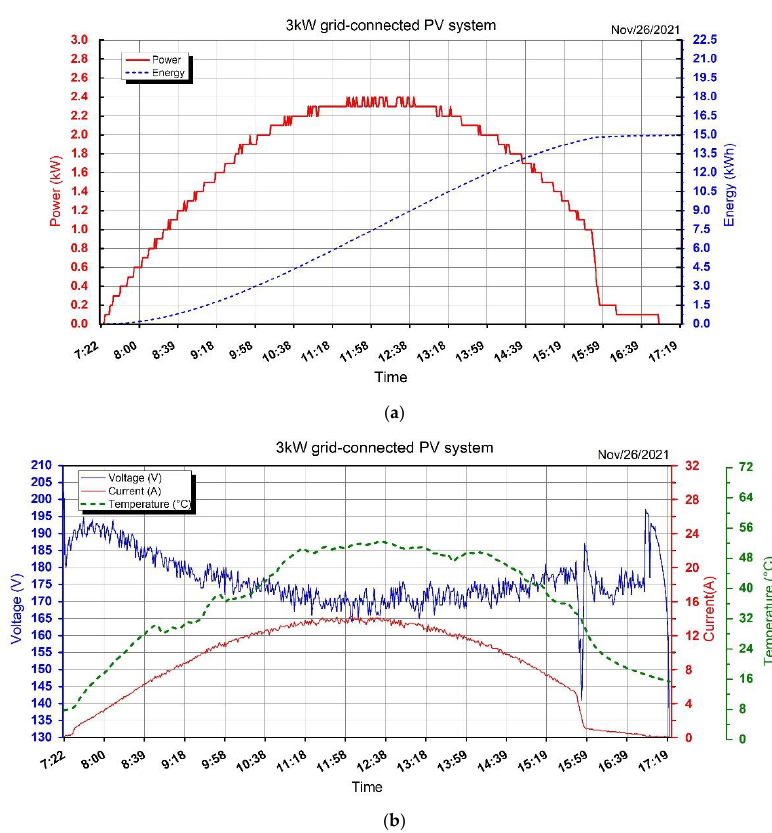
Figure 17. Various data obtained from PV junction box for a day in winter: ( a ) Power and energy flow; ( b ) Voltage, current and temperature flow.